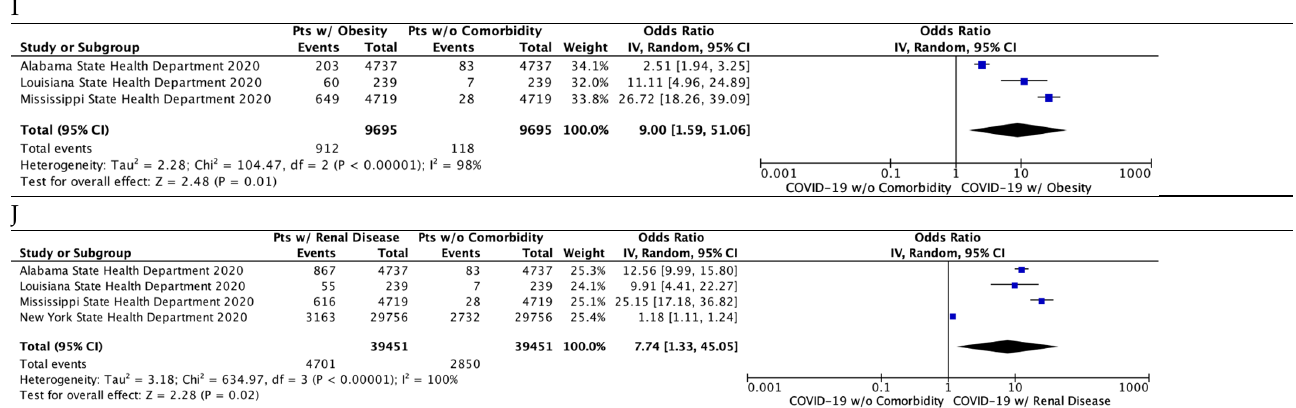
Figure 5. Meta-analysis of the comorbidities with COVID-19. ( A ) Cardiovascular disease (CVD). This odds ratio includes atrial fibrillation, coronary artery disease, hypertension, and stroke from New York’s comorbidity data. ( B ) Chronic kidney disease (CKD). ( C ) Diabetes. ( D ) Hypertension. ( E ) Immunocompromised condition. ( F ) Liver disease. ( G ) Lung disease. This odds ratio includes chronic lung disease from Alabama’s data and COPD from New York’s data. ( H ) Neurological Disease. This odds ratio includes Alzheimer’s disease and stroke data from New York. ( I ) Obesity. ( J ) Renal disease. This odds ratio includes CKD data from Alabama and Louisiana. “Total” columns in the model represent the numerical amount of the total deaths from COVID-19. The “Events” column on the left represents the number of deaths that included the cardiovascular disease comorbidity in that respective state. The “Events” column on the right represents the number of deaths without a comorbidity in that respective state.